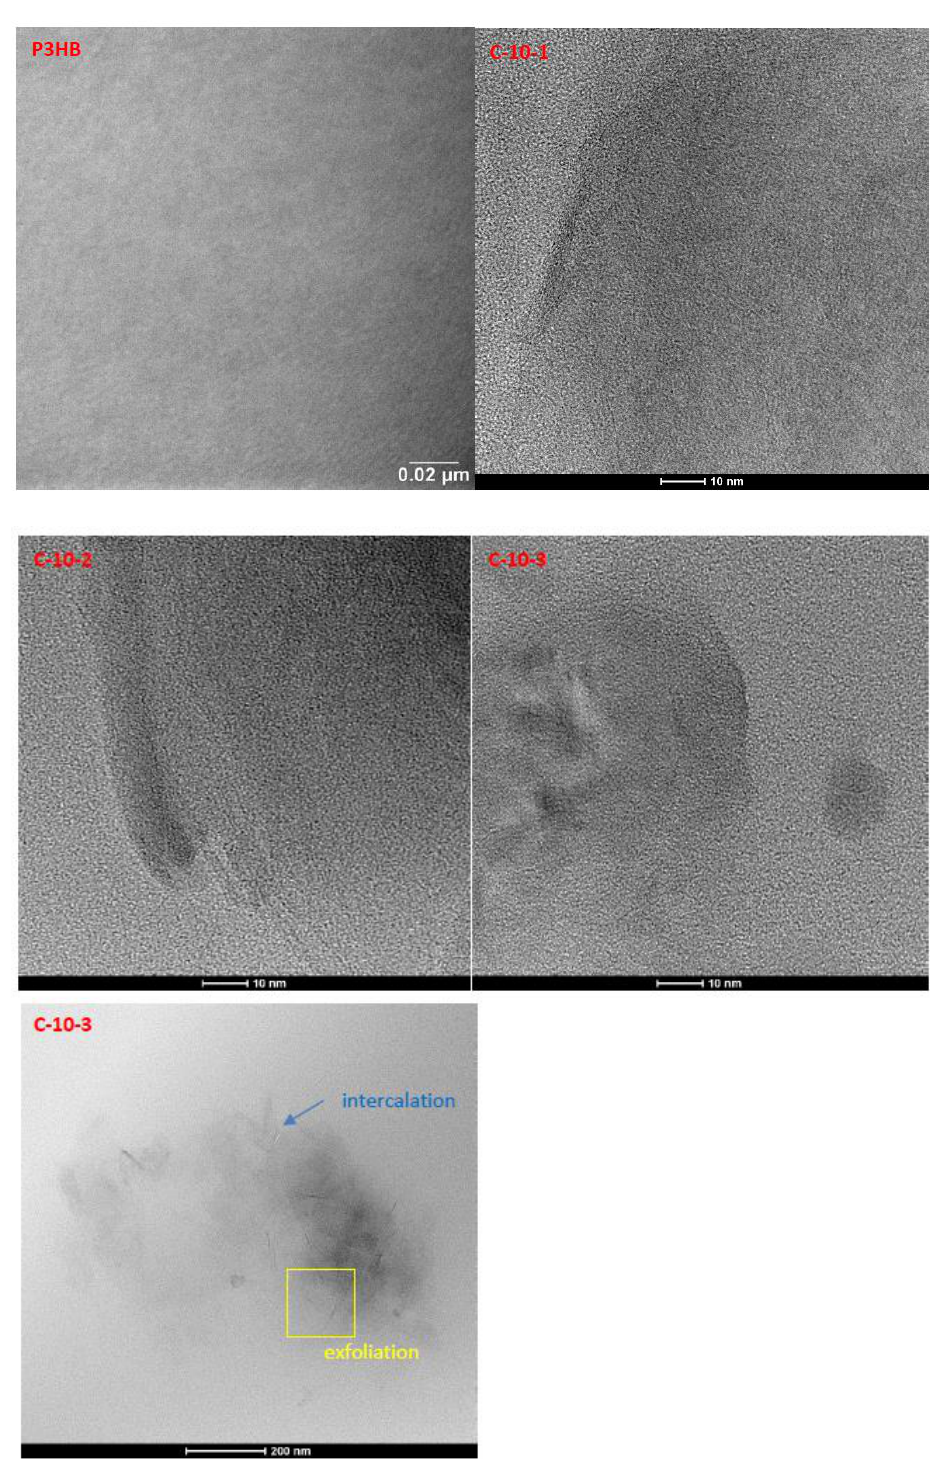
Figure 2. TEM micrographs of P3HB and its hybrid nanobiocomposites with 10 wt.% of PU400 and 1, 2, and 3 wt.% of Cloisite ® 30B, respectively (designated as C-10-1, C-10-2, and C-10-3), (the visible artifacts resulted from the sample preparation).